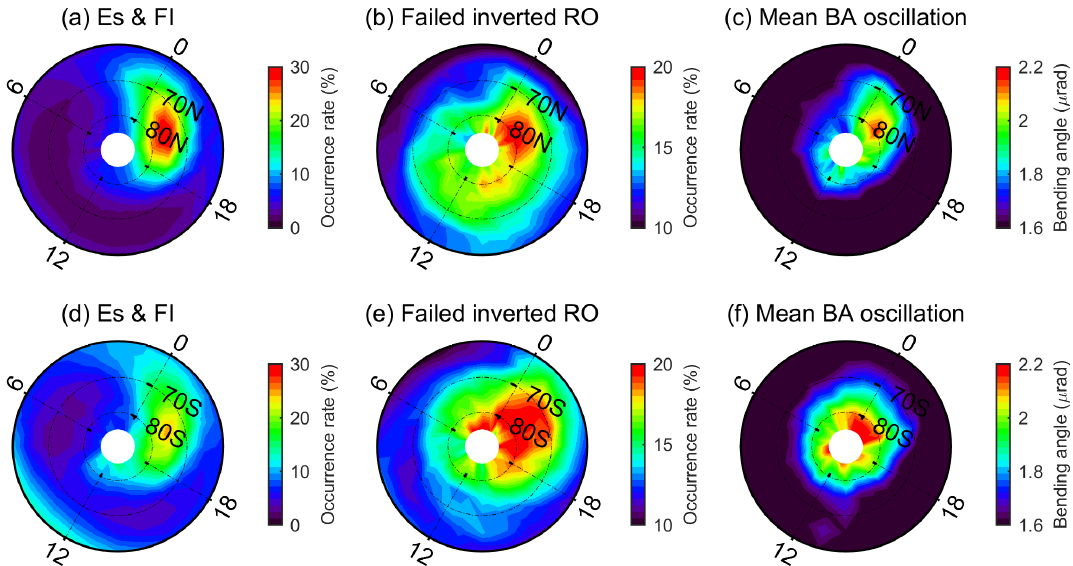
Figure 4. MLT–MLat variation of the E s and F layer irregularity occurrence rate (a, d) , the failed inverted RO occurrence rate (b, e) , and the mean bending angle oscillation (c, f) in polar regions. Please note that the top panels (a–c) represent the results in northern polar regions while the bottom panels (d–f) denote the southern polar regions.